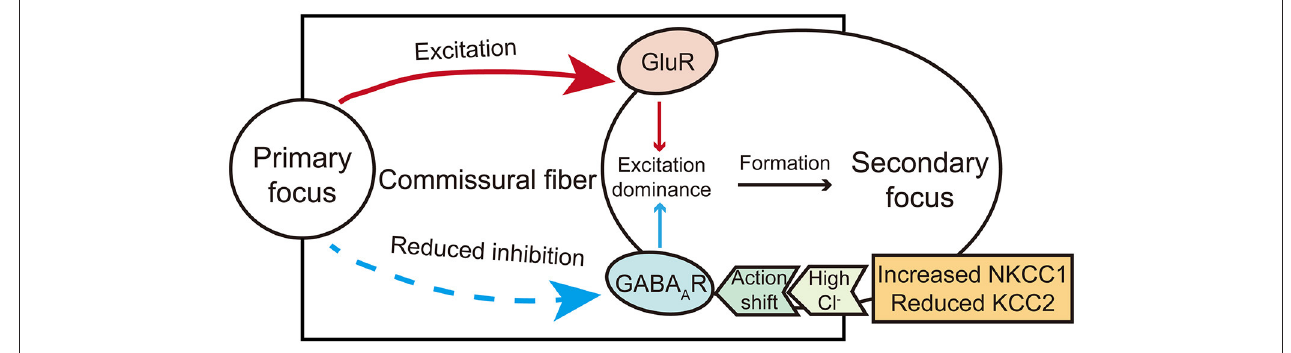
FIGURE 1 | A brief diagram illustrates the action of glutamate and GABA receptors in secondary epileptogenesis. The shift action of GABA from inhibitory to excitatory mediated by chloride co-transporters and excitation actions carried by glutamate commissural fibers co-mediate the formation of the secondary